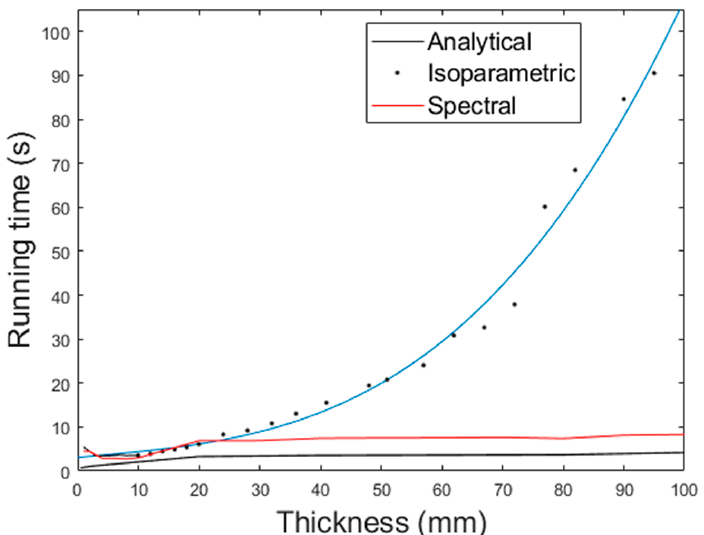
Figure 10. Interpolation order required for convergence with plate thicknesses up to 100 mm.